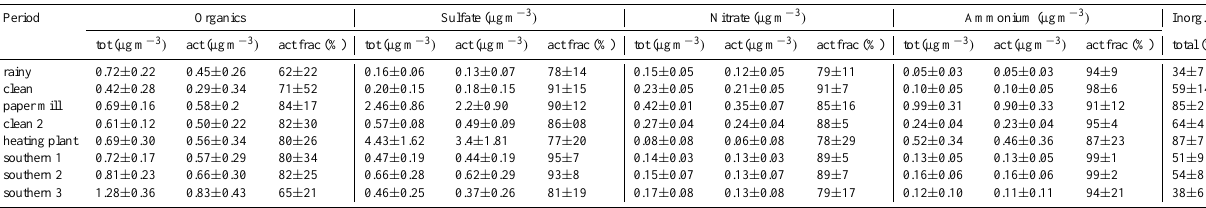
Table 7. Average mass concentrations and standard deviations from the total line, activated concentration (difference in the mass concentra- tion between total and interstitial lines) and activated fraction of chemical constituents for the different periods of the cloud event observed on 22–24 October